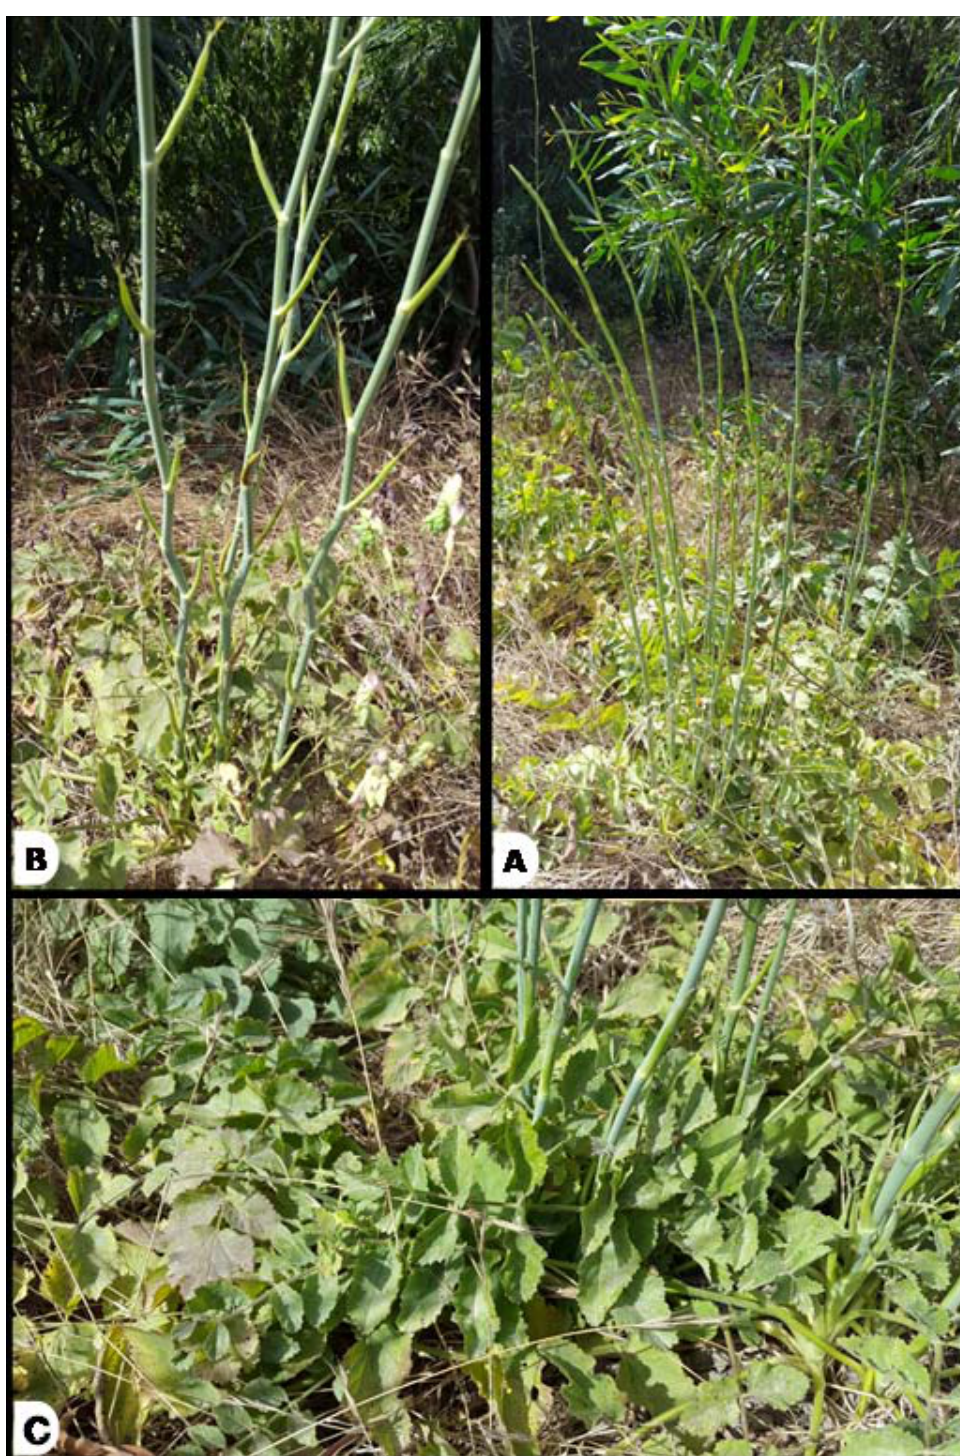
Figure 1. Tunisian Pimpinella lutea Desf. (Tabarka, NW of Tunisia). ( A ) The habit of the plant in one of its natural habitats; ( B ) Long, glabrous stems with leaves reduced to sheaths; ( C ) Basal leaves long, typically pubescent, soft, pinnate with ovoid or rounded segments. (Photographs by Ridha El Mokni).